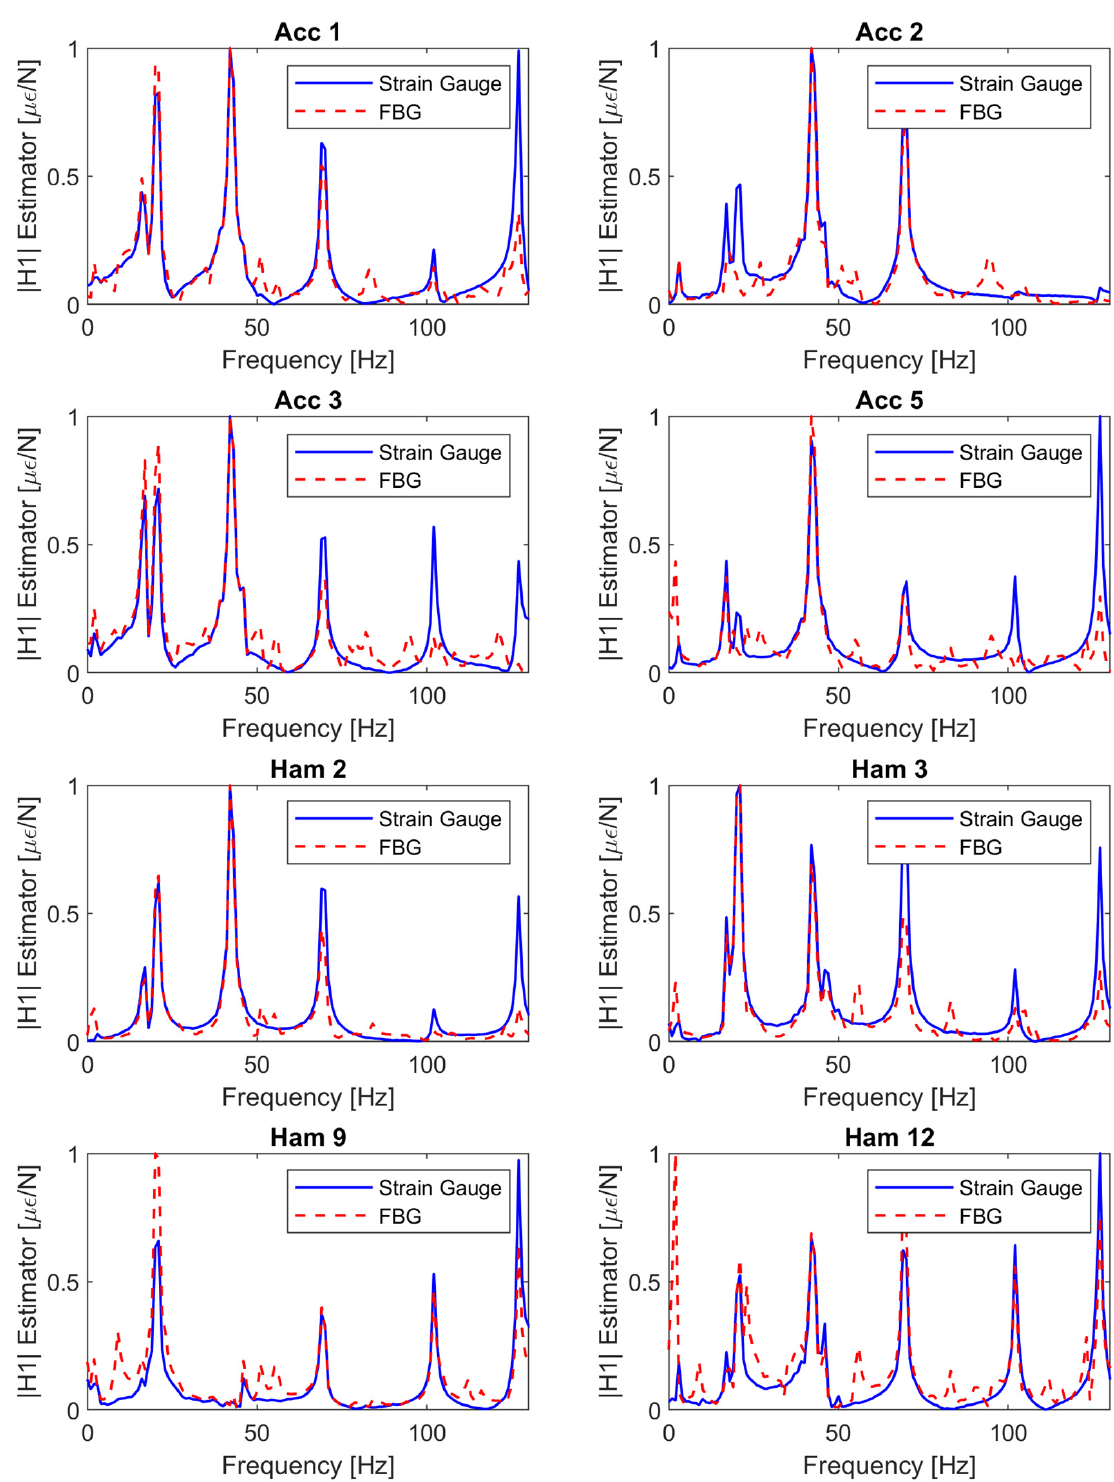
Figure 6. Electrical SG and FBG SFRF comparison at several hammer excitation locations.